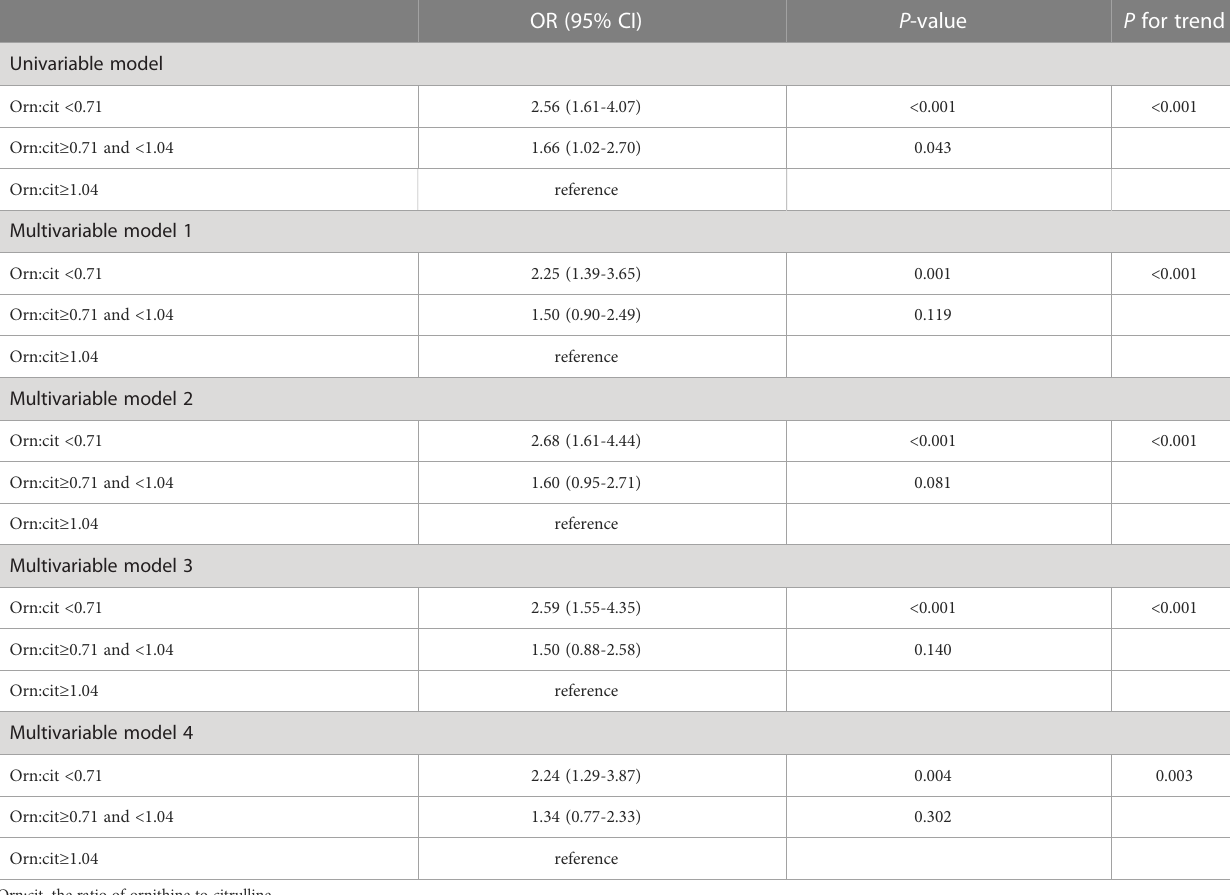
TABLE 4 Odds ratios of orn:cit for the risk of